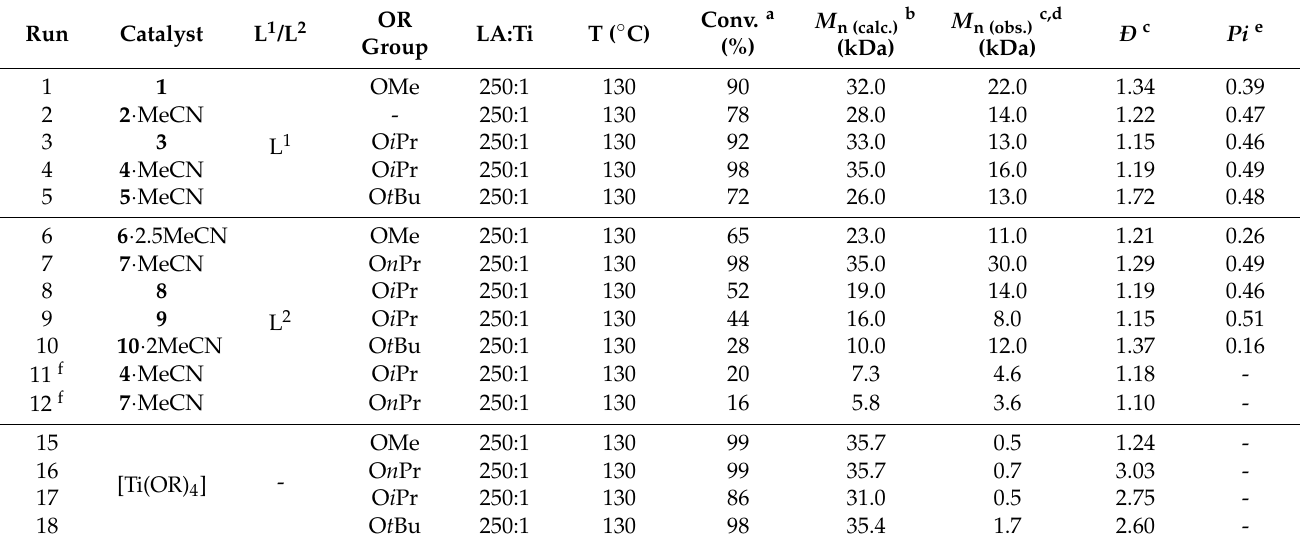
Table 3. ROP of r- LA catalyzed by Ti complexes 1–10 and [Ti(OR) 4